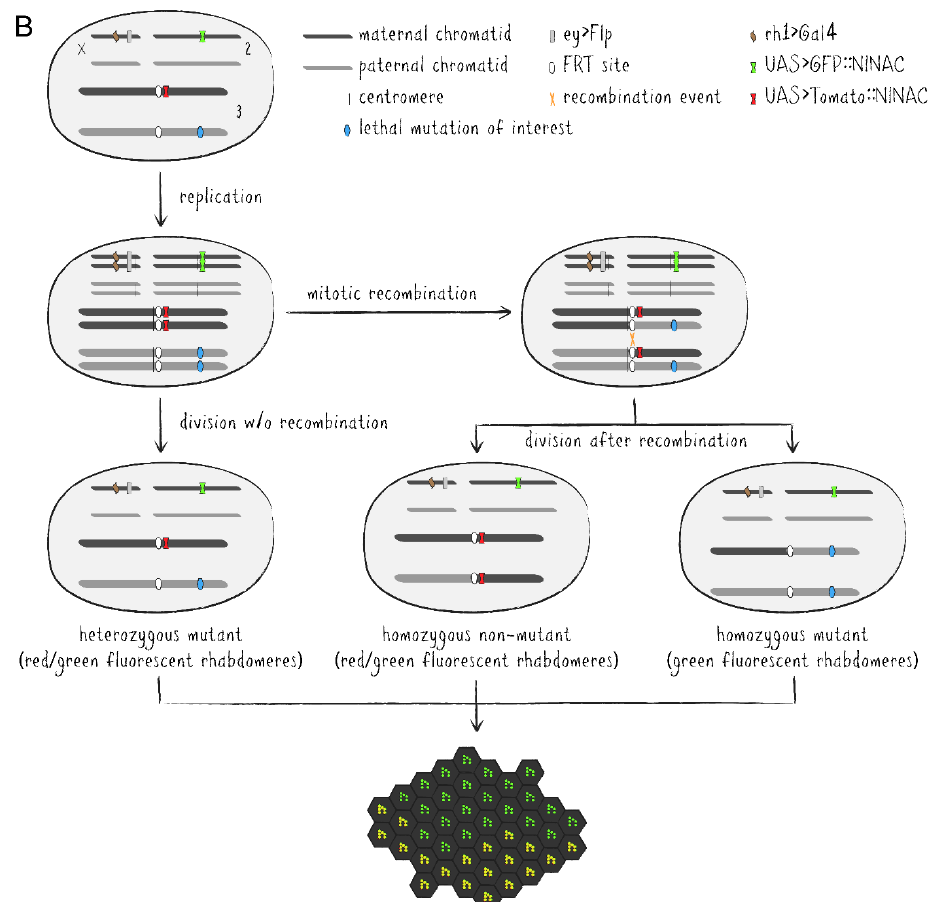
Figure 3. Schematic representation of mosaic tissue generation by mitotic recombination events via the Flp/FRT system adapted from Saccharomyces cerevisiae . ( A ) Conventional mosaic technique applied during Drosophila eye development utilizing pigmentation as phenotypic marker. ( I ) Heterozygous diploid cells with one maternal (dark grey bar) and one paternal (light grey bar) copy of chromatids (X and 3 illustrated, 2 and 4 not shown). Both X chromatids are mutant for the eye pigmentation gene white (white rhombus, w – ). The yeast flippase gene is expressed eye-specifically from the maternal X chromatid by the enhancer of the eyeless gene (grey rectangle). In this example, both copies of the third chromatid carry a flippase recognition target (FRT) site (white oval) at the identical genomic locus of the same arm close to where the centromere will form. Distal on the same chromatid arm, the maternal copy carries a functional white gene (red rhombus, w + ) as phenotypic cell clone marker, while the paternal copy carries the lethal mutation of interest (blue hexagon). ( II ) During development, chromatids are replicated into chromosomes tethered at the centromere (vertical line). ( III ) Flippase expression may lead to a recombination event (orange cross) between two homologous chromosome arms. ( IV ) If the recombination event exchanged a maternal for a paternal arm, cell division results in the generation of genetically distinguishable progeny. Cells receiving chromatids with two maternal arms are homozygously non-mutant for the gene of interest but carry both copies of w + , thus producing red pigmented retinal tissue (center). Cells receiving chromatids with two paternal arms are homozygously mutant for the gene of interest and carry no pigmentation marker, resulting in non-pigmented retinal tissue (right). ( V ) In the absence of a recombination event or in case of an exchange of identical sister chromatids, cell division generates heterozygously mutant progeny which also forms red pigmented retinal tissue due to the presence of one copy of w + (left). ( VI ) Adult eyes display mosaics of red and white ommatidia originating from w – and w + cell clones, respectively. White regions are homozygous for the lethal mutation of interest and can be investigated immediately adjacent to red pigmented non-mutant tissue. ( B ) Advanced variant for mosaic eyes in Drosophila utilizing two fluorescent proteins instead of eye pigmentation as phenotypic markers. The Gal4 transcription factor is expressed in outer photoreceptor cells by the Rh1 promoter (brown ribbon) and drives expression of both FP::NINAC fusion proteins under UAS control (green/red hourglasses). Homozygously mutant retinal tissue exclusively exhibits green fluorescence of rhabdomeres R1–6, while heterozygously mutant and homozygously non-mutant tissue displays green and red fluorescence simultaneously, appearing with yellow rhabdomeres in